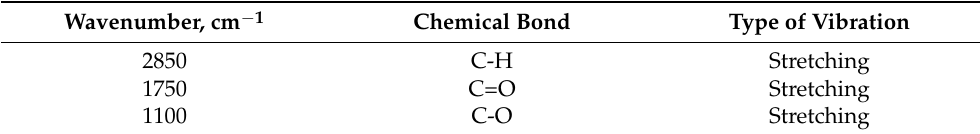
Figure 8. FT-IR spectra showing the influence of incubation on the structure of hydrogels obtained using varying amounts of PEGDA 700, i.e., 1.5 mL ( a ), 2.0 mL ( b ) and 2.5 mL ( c ). FT-IR analysis was used to determine the potential changes in the structure of hy- drogels obtained using varying amounts of crosslinking agent with an average molecular weight of both 575 g/mol and 700 g/mol. Table 1 shows the absorption bands observed in the spectra with corresponding chemical bonds, as well as the type of vibration. Table 1. Absorption bands in FT-IR spectra with corresponding chemical bonds, as the type of vi- brations.